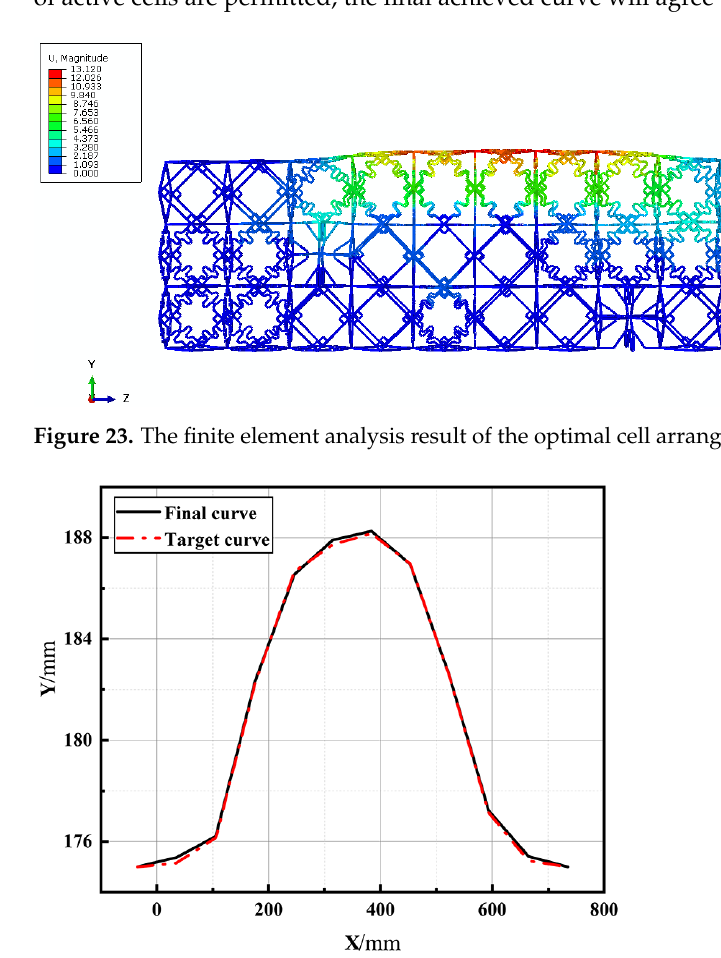
Figure 24. The comparison between the target curve and the final curve of the optimal cell arrangement. Table 2. Number and weight of six kinds of fundamental unit cells.